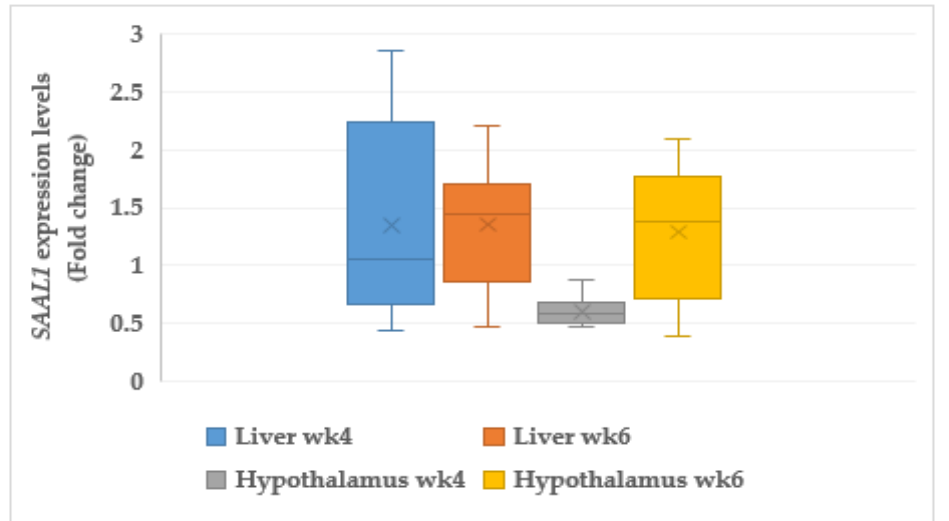
Figure 4. Expression profile of serum amyloid A like 1 ( SAAL1 ) in the muscle, liver, and heart at week 4 and 6 in corticosterone-fed chickens (fold-change). wk4 = 4 weeks of age (2 weeks of CORT administration); wk6 = 6 weeks of age (4 weeks of CORT administration); n =